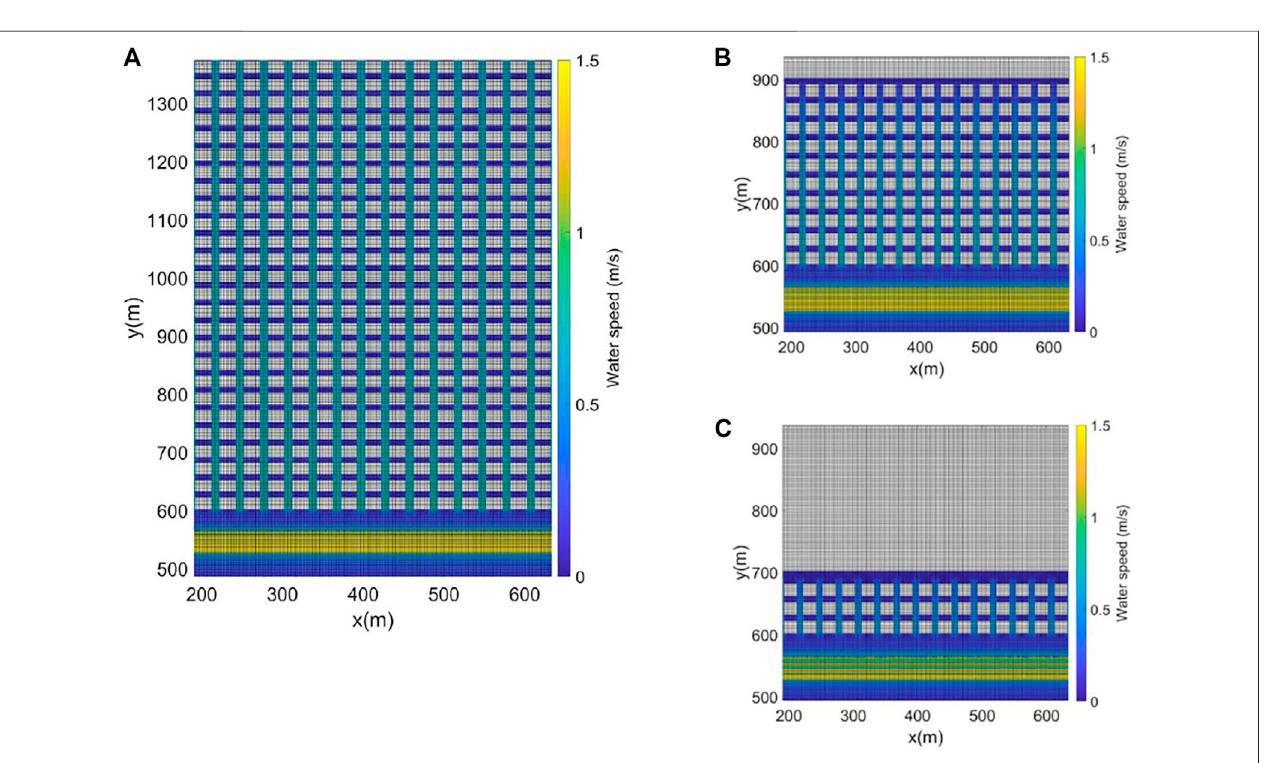
Frontiers in Built Environment |